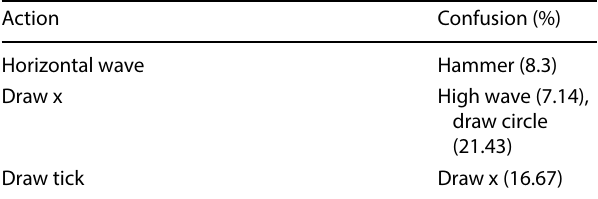
Table 4 Class oriented confusion on DHA